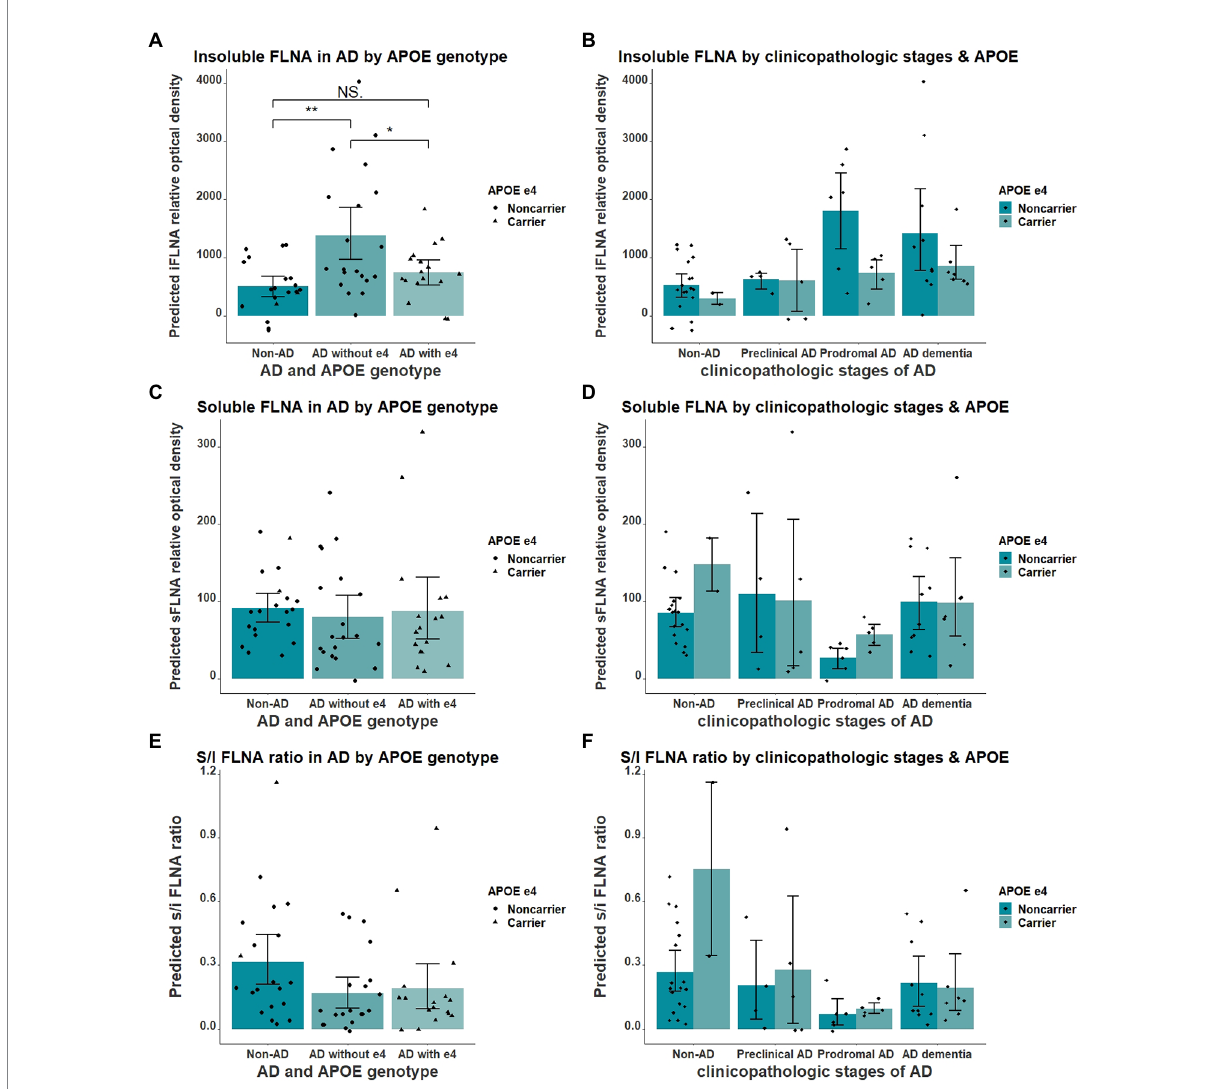
FIGURE 5 Interaction of APOE ε 4 and AD over the levels of FLNA. (A) Insoluble FLNA (iFLNA) is significantly increased in participants with AD that do not carry APOE ε 4 when compared to AD carriers and non-AD subjects. (B) This contrast is most apparent at the prodromal stage of AD. (C–F) No significant effect of APOE ε 4 on either soluble FLNA (sFLNA) of soluble over insoluble (s/i) FLNA ratio in AD was found. Predicted soluble and insoluble FLNA values shown were calculated by adding the mean to the residual values from age, sex and study batch linear regression. *: p < 0.05; **: p <